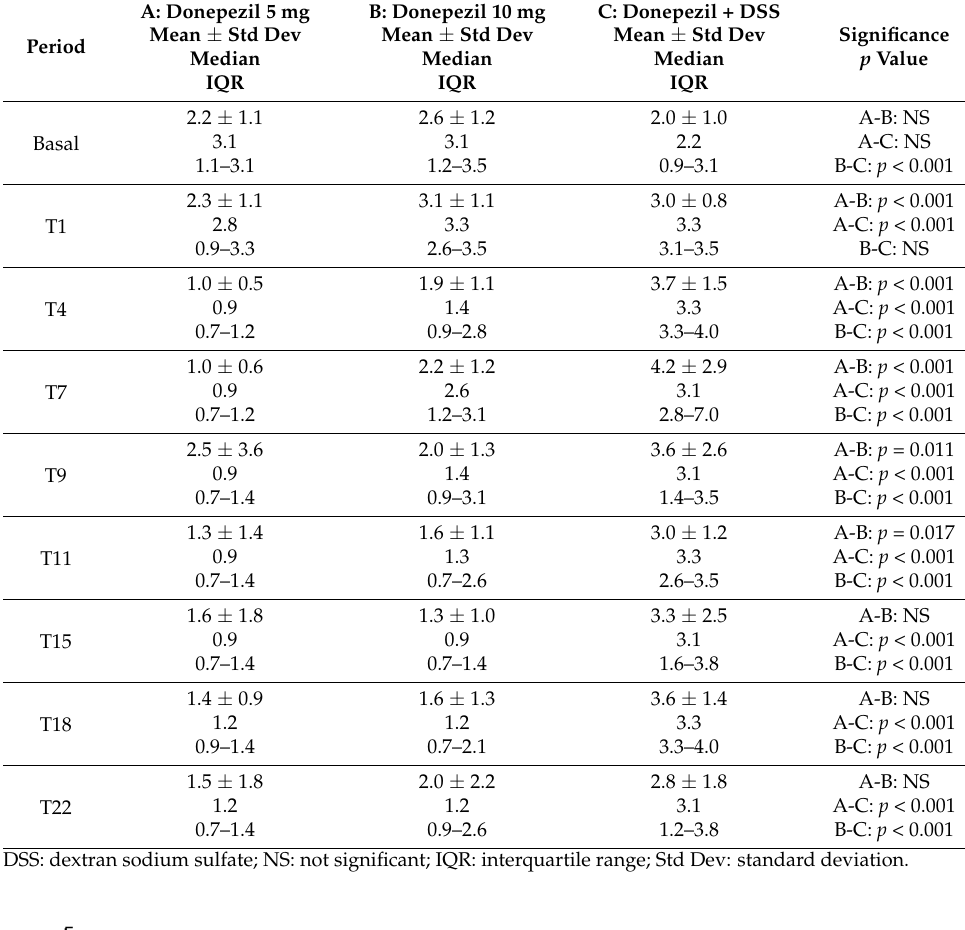
Table 3. Electrogastrography. Dominant frequency (cycles per minute).